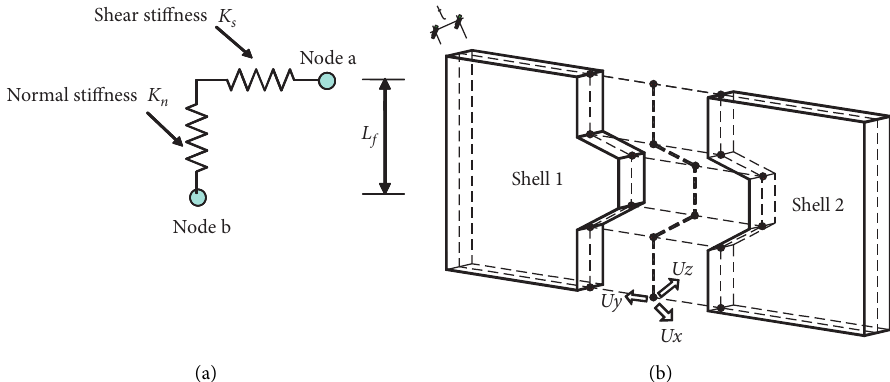
Figure 16: Line-to-line connected interface element CL24I [21]: (a) stiffness and nodes of CL24I; (b) mechanic behaviors of